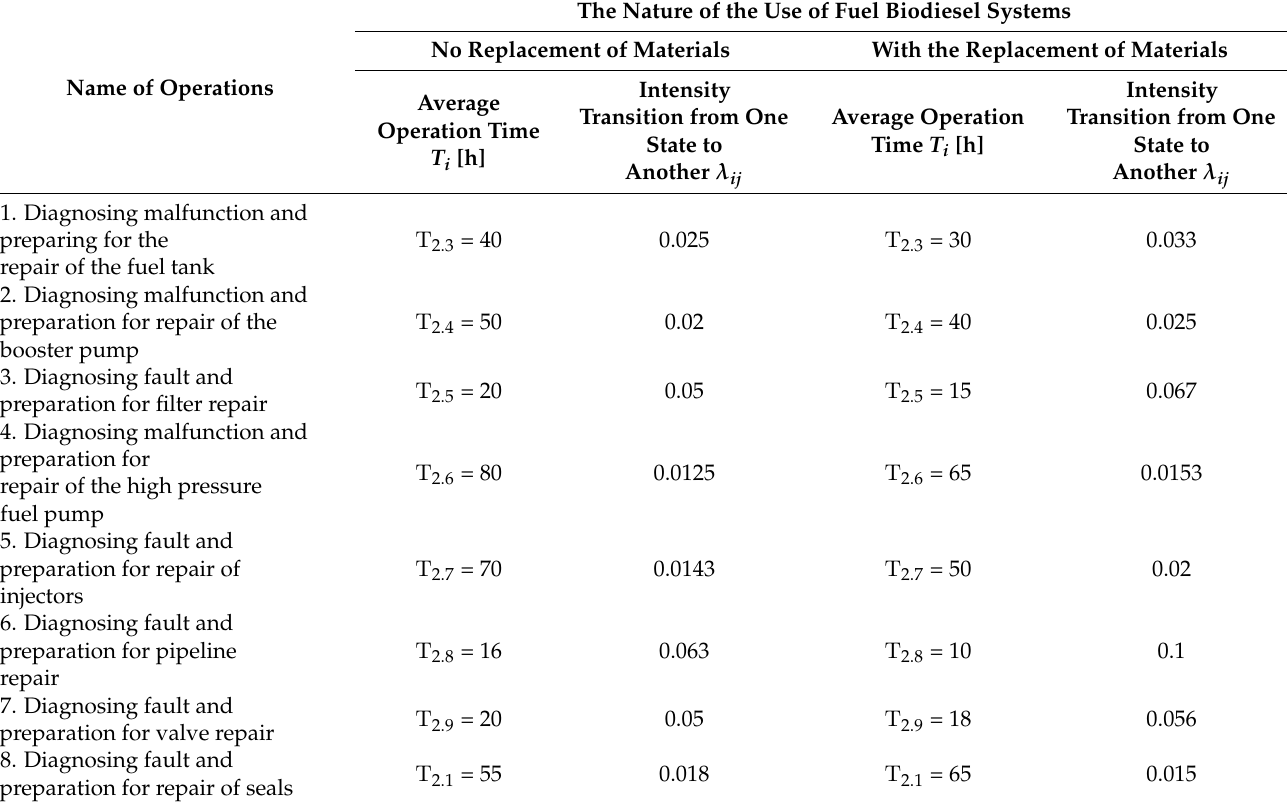
Table 1. The average values of the time for performing technological operations on the diagnostics of fuel